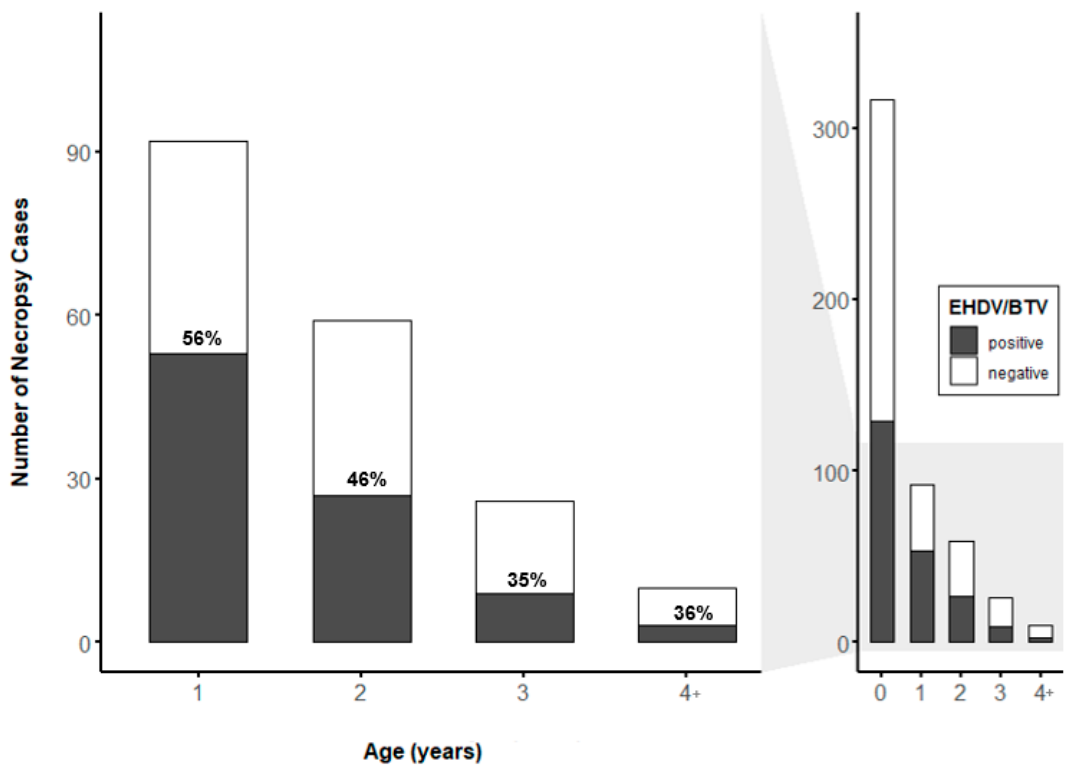
Figure 2. Age distribution (years) of dead farmed white-tailed deer (WTD; n = 527) sampled from Florida deer farms for RT-qPCR testing for epizootic hemorrhagic disease virus (EHDV) and bluetongue virus (BTV). Labels within bars represent the percentage of WTD testing positive for EHDV or BTV by age class.